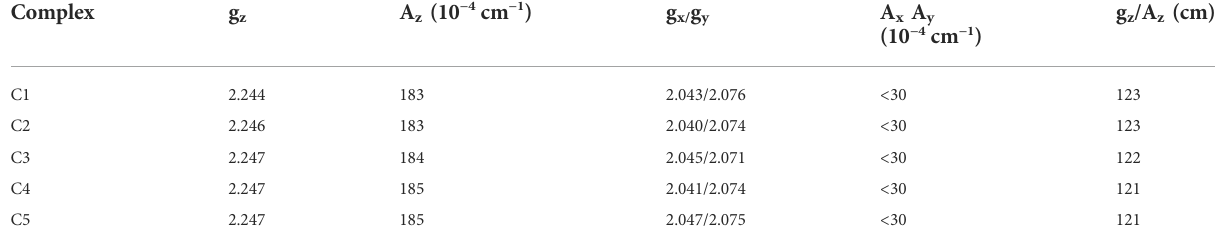
TABLE 1 EPR parameters from X-EPR band spectra of complexes C1-C5. Spectra were recorded at 120 K in frozen DMSO solutions. g z /A z ratio is a parameter that predicts the distortion from planarity of the structure (g z /A z > 140 cm to consider a planar distortion in the structure).